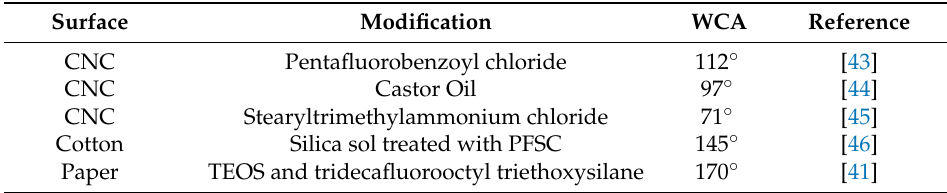
Table 2. Hydrophobic Treatment of Cellulose-based Materials (PFSC: perfluorooctylated quaternary ammonium silane coupling agent; TEOS: Tetraethyl